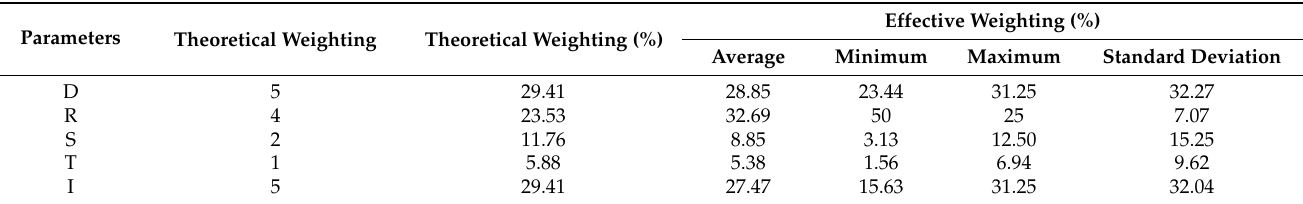
Figure 14. Spatial distribution of groundwater sulfur concentrations on the groundwater vulnerability map of the Ouixane mining district. Table 3. Statistical analysis results of the single parameter sensitivity of the DRSTI